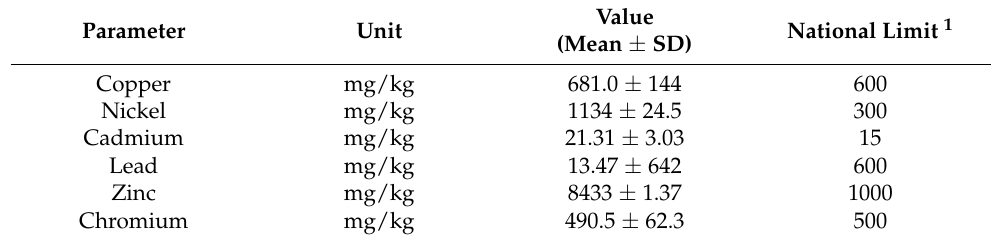
Value National Limit 1 (Mean ± SD)